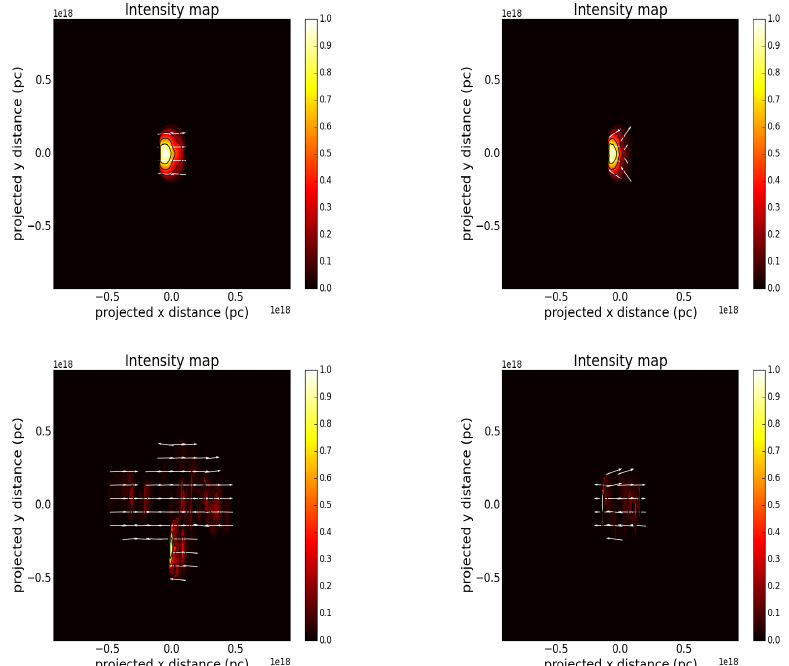
Figure 2. Left: Normalized intensity map (Stokes I ) at t = 0 ( top ) and t = 3 ( bottom ) for σ = 10 − 3 . Right: Normalized intensity map at t = 0 ( top ) and t = 3 ( bottom ) for σ = 10 − 1 . The arrows represent the electric field vector, as calculated from Equation (5). Viewing angle is θ obs = 5 ◦ , flow direction is outwards.